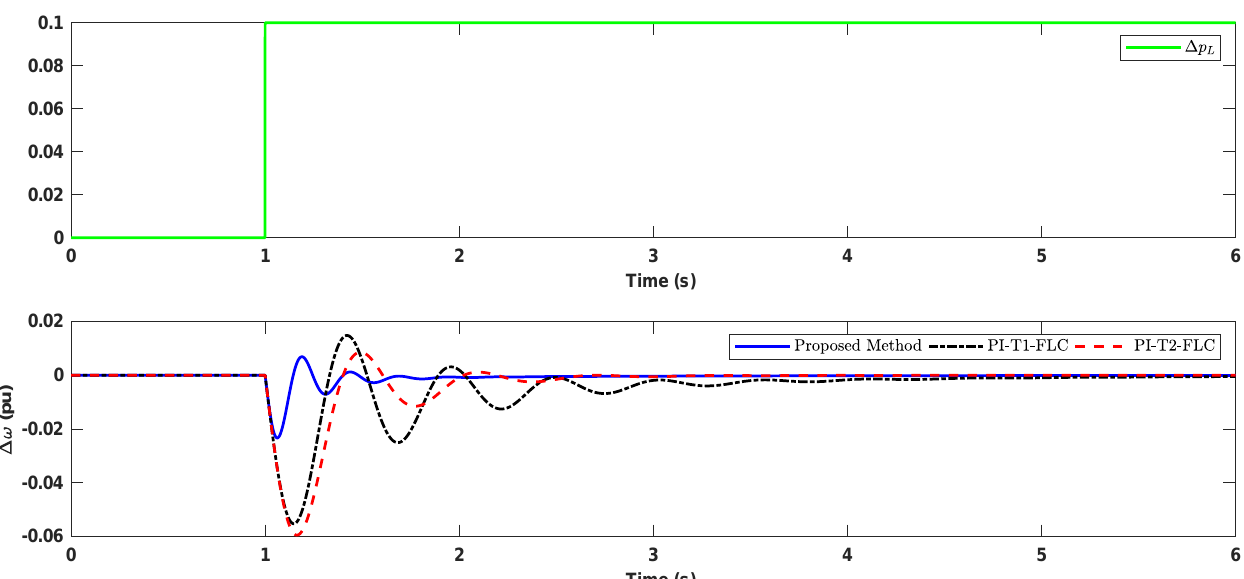
Figure 7. Example 1: Scenario 1: Frequency regulation performance in the presence load changes.